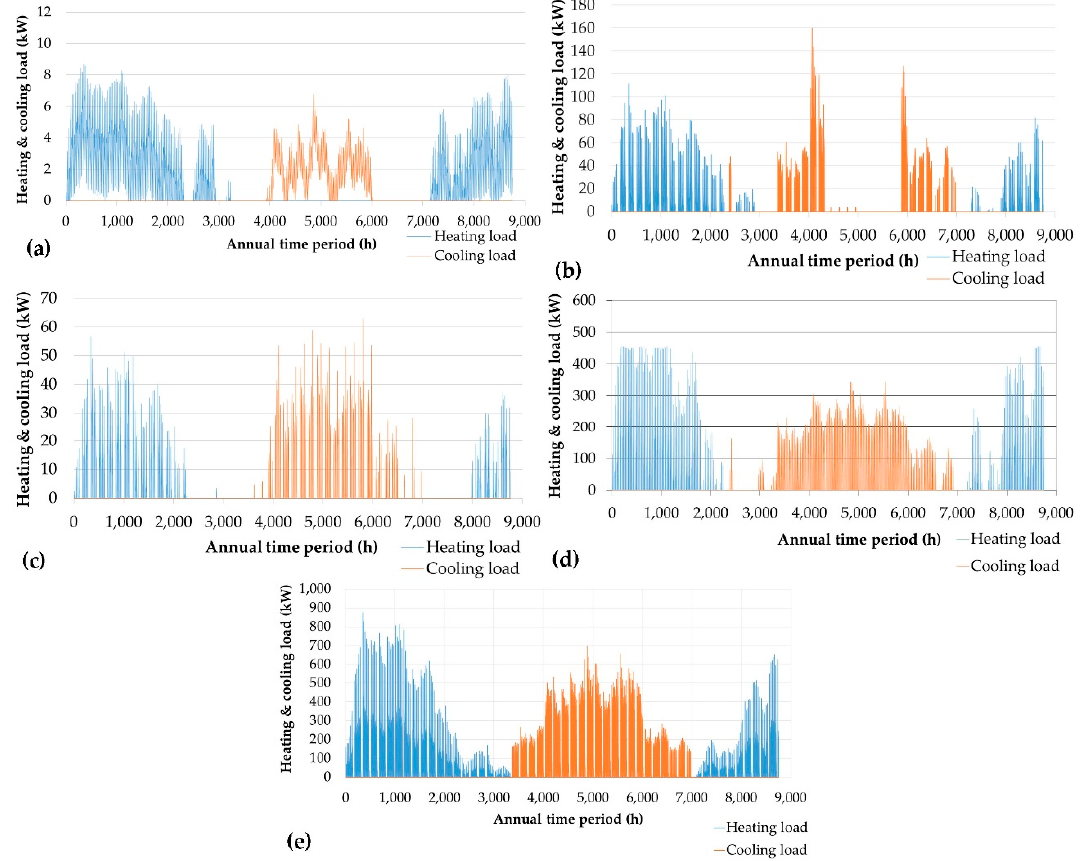
Figure 14. Annual fluctuation of the heating and cooling loads in the examined buildings after the integration of the proposed passive measures (( a ): residential building, ( b ): school building, ( c ): municipality hall, ( d ): NHMC, ( e ): Pancretan Stadium).